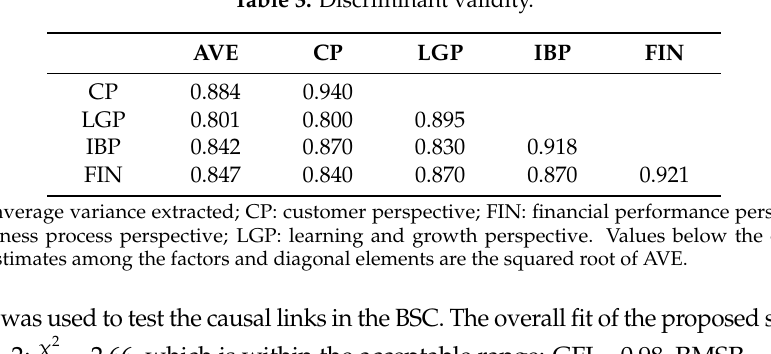
Table 3. Discriminant